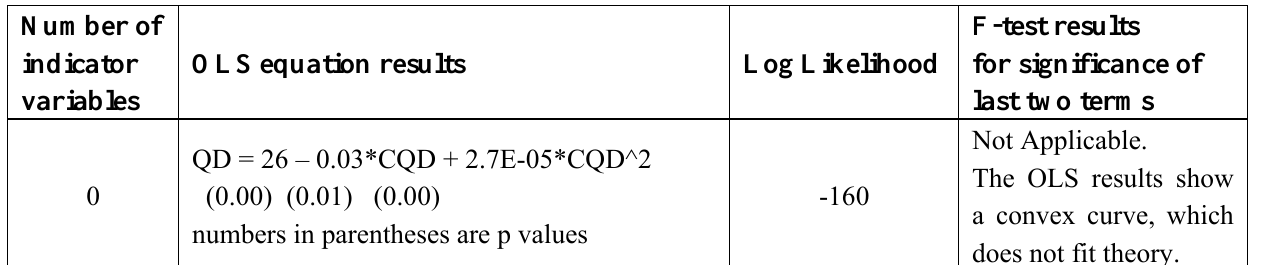
Table 1. Single Hubbert Cycle OLS results.